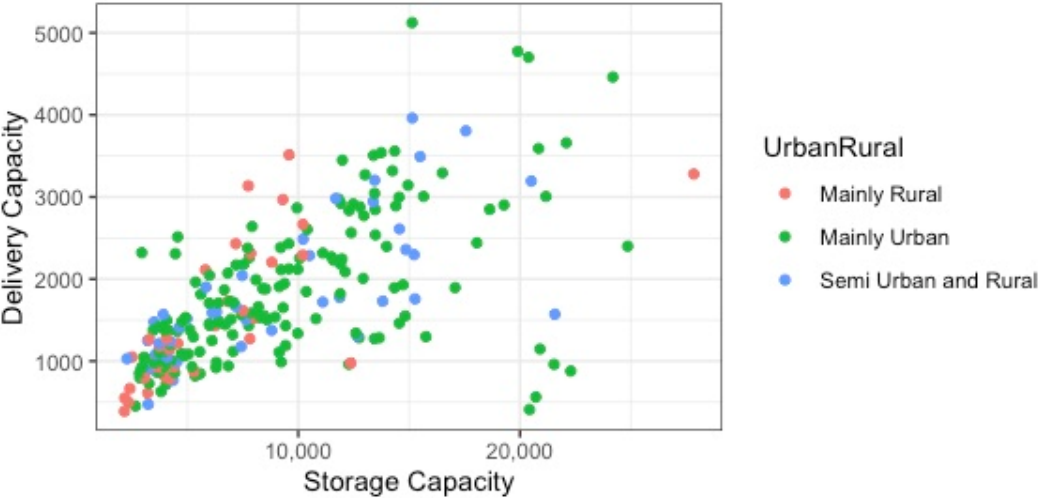
Figure 2. Capacity constraints associated with storage (combining ambient and chilled) and delivery at the store level, by area type.